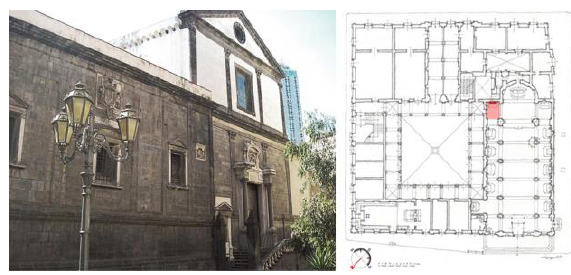
Figure 1 . The Church of Santa Maria la Nova in Naples, Italy. In red, the Chapel of SS. Maria delle Grazie.